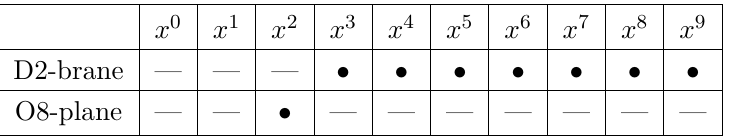
Table 1 . The brane intersection. In the above notation — denotes that the D-brane or the O-plane extends along that particular direction, while • means that the coordinate is transverse to their